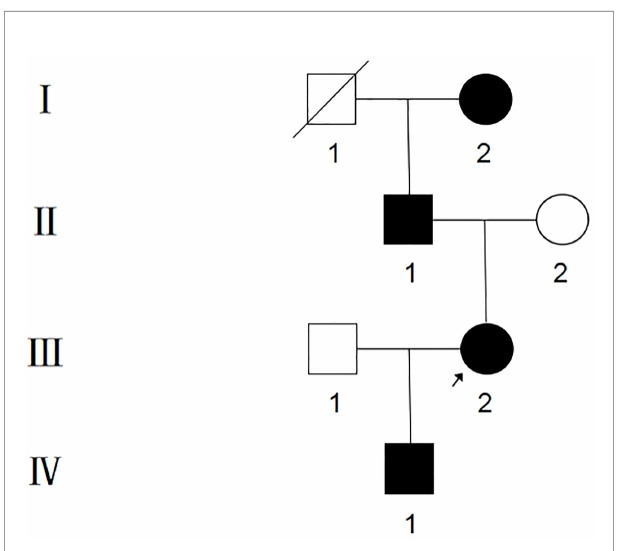
FIGURE 1 | Pedigree of Chinese family with NHGF. Affected individuals are indicated by blackened symbols. Circles and squares denote female and male members respectively, and a slash through a symbol denotes a deceased individual. The proband is indicated by the arrow.